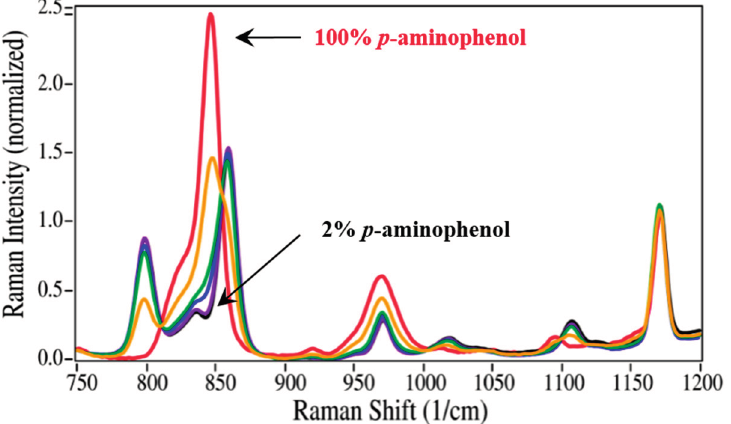
Figure 6. Raman spectra of p -aminophenol mixed with acetaminophen at 100, 50, 20, 10, 5, and 2 mass %, all normalized to the 1170 cm − 1 peak height set equal to 1. Inset: graph and values of prepared versus calculated mass % based on peak height at 846 cm − 1 . Spectral conditions as in Figure 2, except ten one-minute spectra were averaged for each concentration.